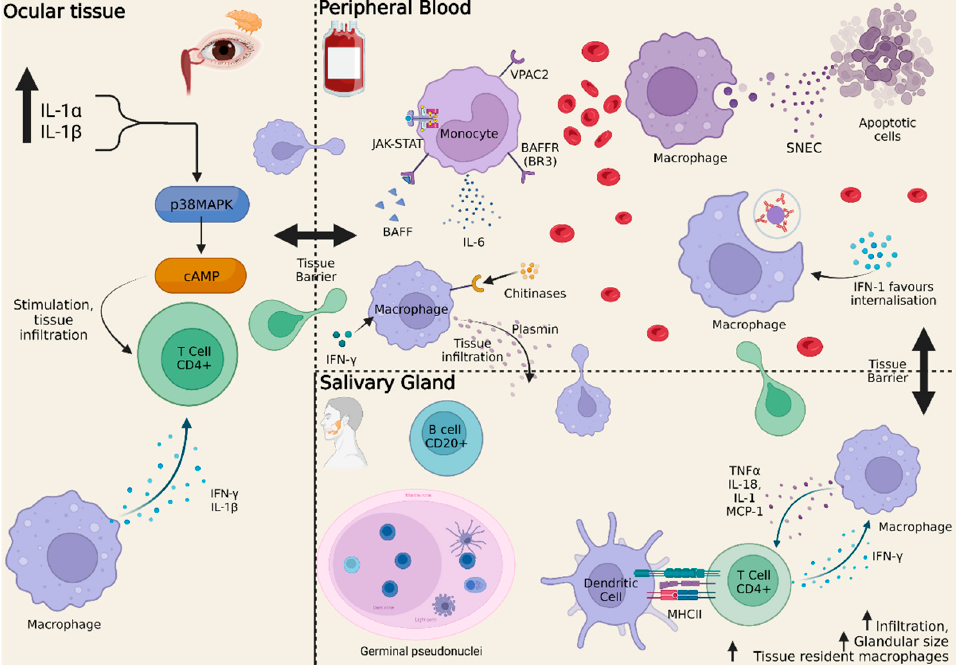
Figure 1. Monocyte and macrophage implication in Sjögren’s Syndrome. This figure shows how the monocyte/macrophage infiltrates peripheral tissues, namely ocular and salivary, interacting with B and T cells, and sustaining inflammation, disease progression, and organ disease damage. IL-1 α , Interleukin-1 α ; IL-1 β ; IL-18; IL-6; p38 MAPK, p38 MAP-Kinase; cAMP, cyclic Adenosine monophosphate; IFN- γ , Interferon- γ ; IFN-1; TNF α , Tumour necrosis factor α ; MCP-1, Monocyte chemotactic protein 1; SNEC, secondary necrotic material; MHCII, Major histocompatibility complex type II; JAK, Janus-kinase; BAFF, B cell activating factor belonging to TNF family; VPAC, Vasoactive intestinal peptide receptor. Created with www.BioRender.com. Accessed on 17 October 2022.